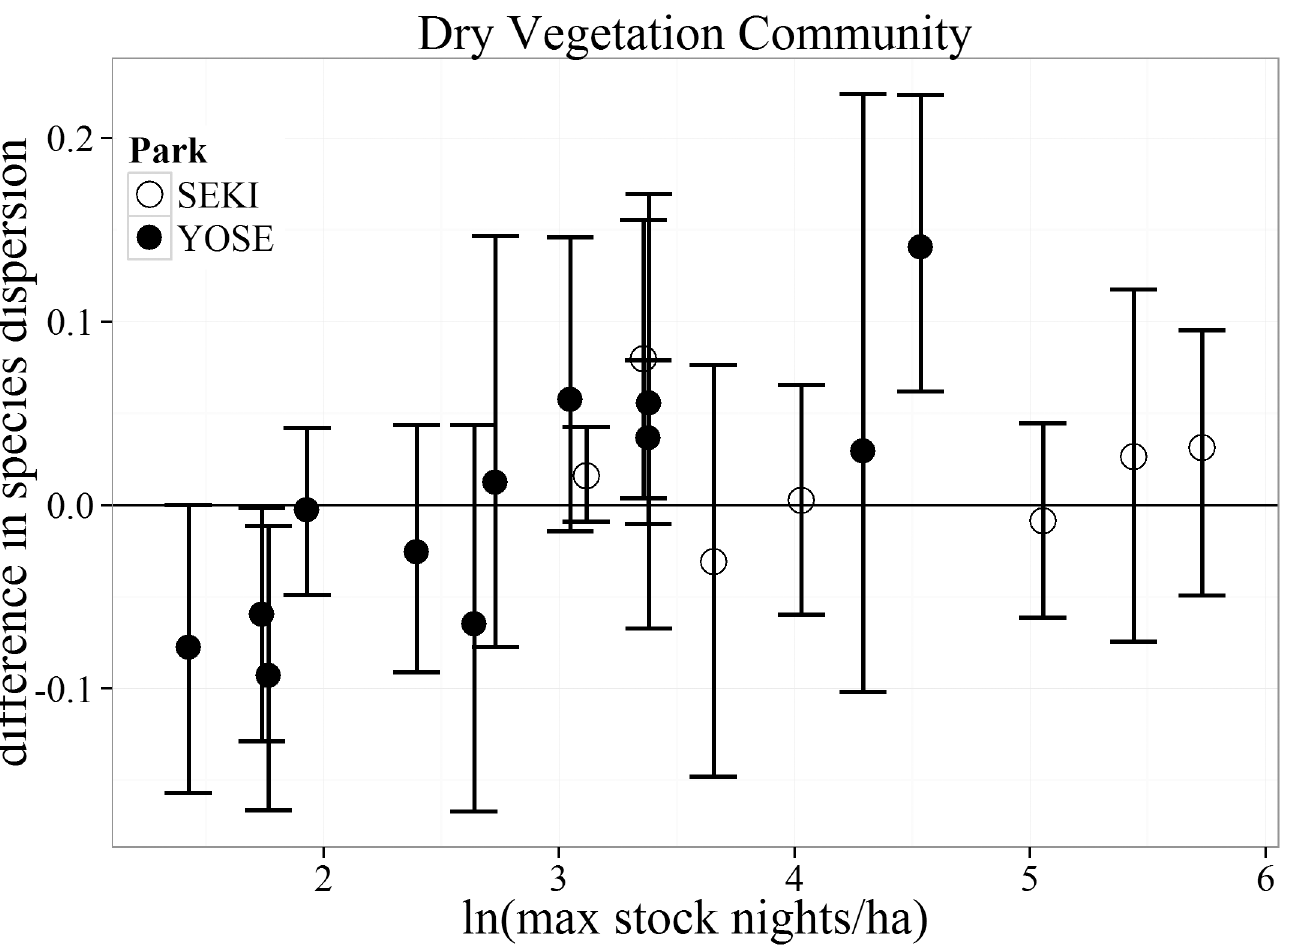
Fig 5. Bootstrapped mean (with 95% confidence intervals) differences in species dispersion for the Dry vegetation community between matched meadows (N = 19) in Yosemite (YOSE) and Sequoia (SEKI) National Parks. The range of 1–5.7 (ln) maximum stock nights/ha corresponds to a range of 4–308 untransformed maximum stock